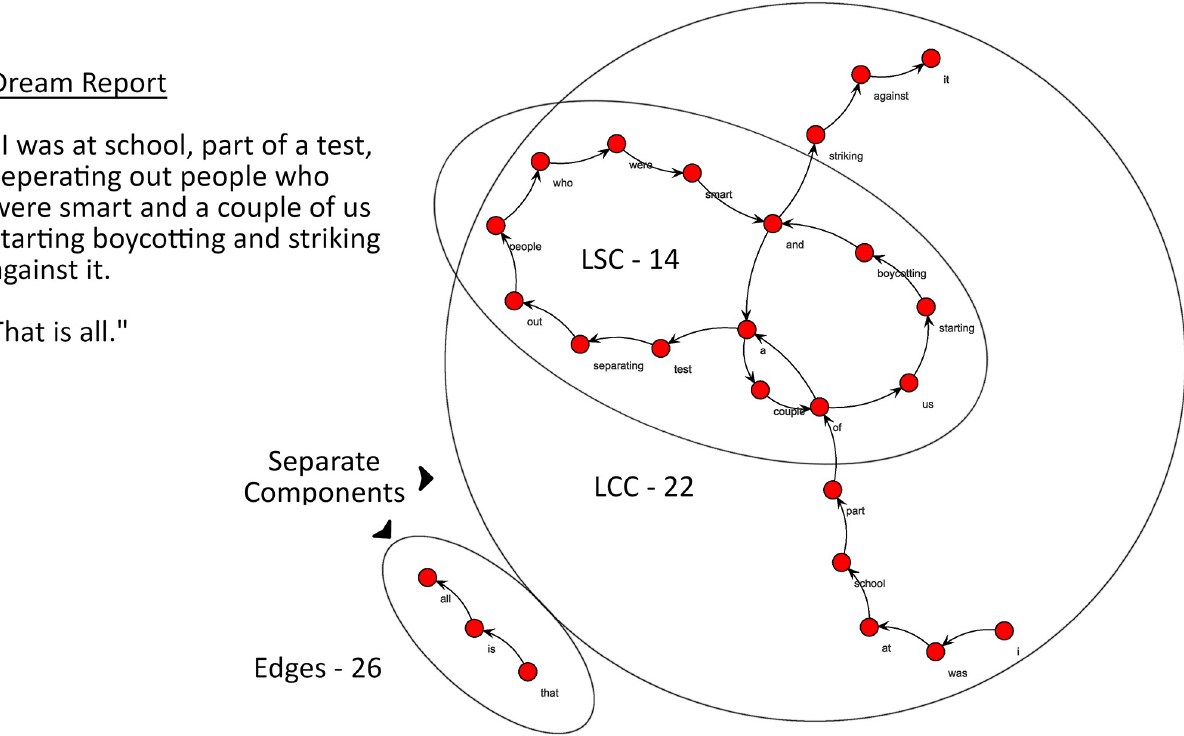
Fig 1. Word graph analysis applied to dream reports. Dream report represented as a directed word graph. Nodes indicated in red, edges indicated as black arrows. There are two components in this graph: one with three nodes and the other with 22 nodes. LCC and LSC measures are derived from the larger